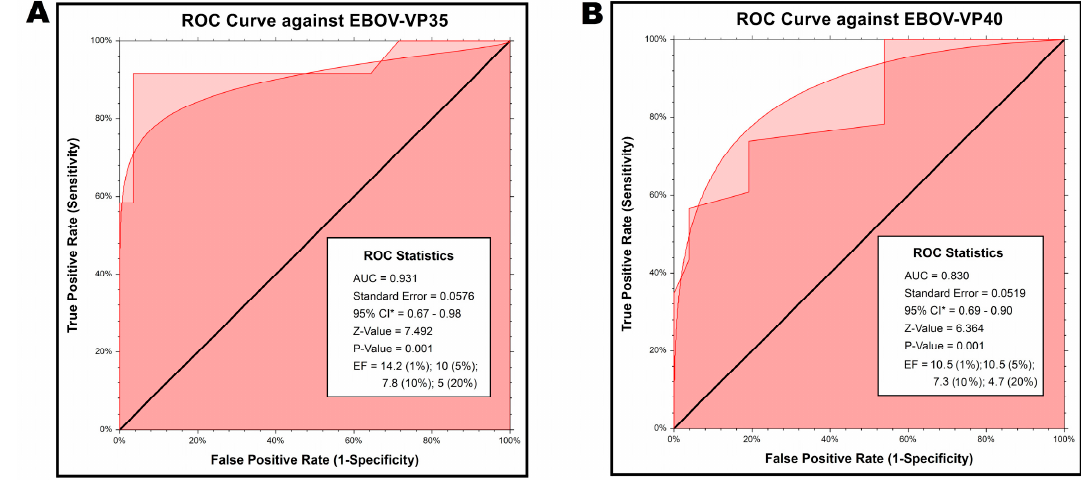
Figure 8. ROC curve analysis. ROC curve analysis of actives and inactives for detecting the performance of the VS method being employed, with the true- and false-positive rates in the X - and Y -axis, respectively; ( A ) The AUC of 0.931 (95% CI, 0.67–0.98) against EBOV-VP35; ( B ) the AUC of 0.830 (95% CI, 0.69–0.90) against EBOV-VP40. ROC, receiver operating characteristic, both by binomial and empirical approach; AUC, area under the ROC curve; CI, confidence interval; Z-value, Z-score for testing the designated hypothesis test; p -value, probability level associated with the Z-value; EF, Enrichment factor.